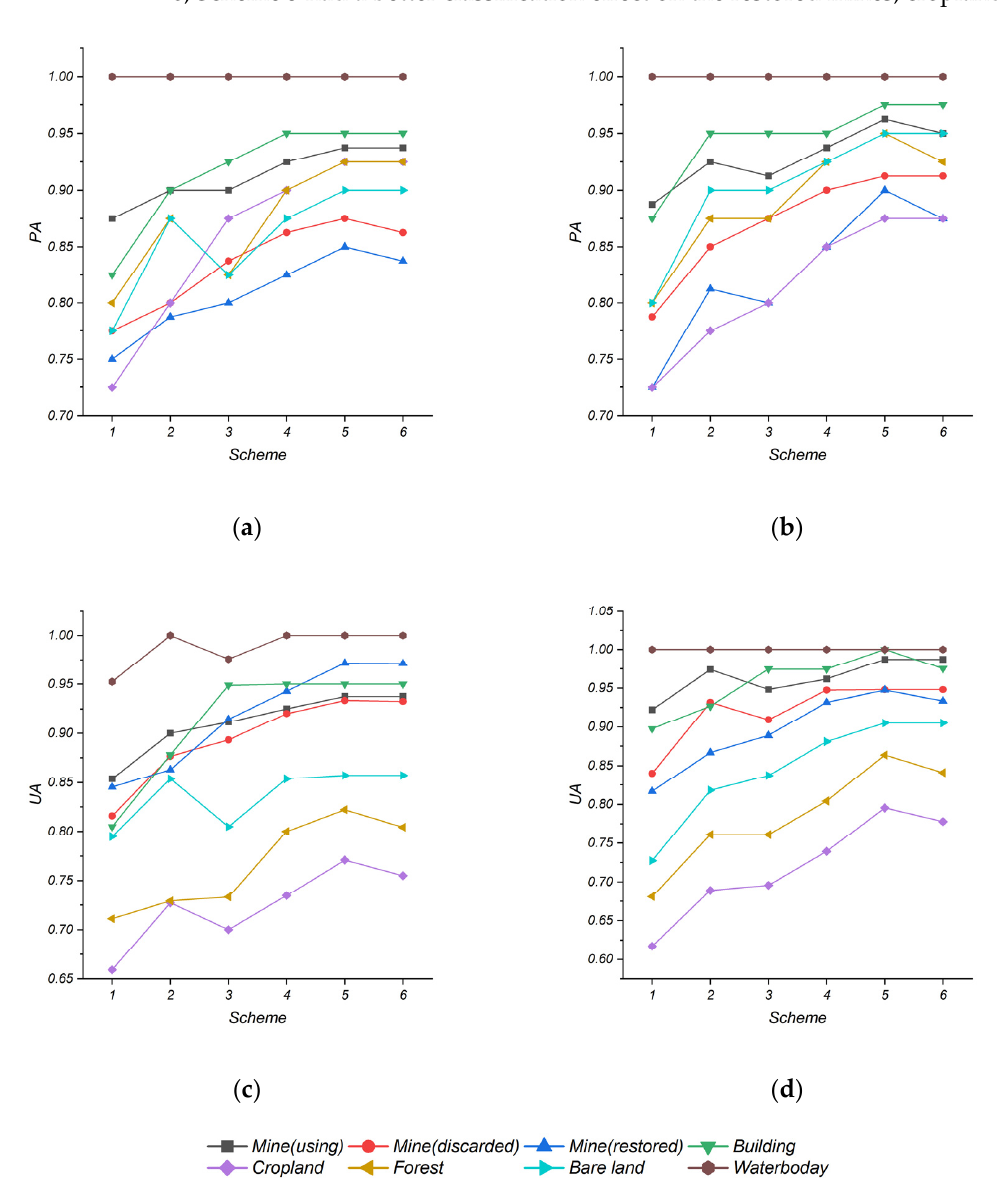
Figure 11. (Top) Producer accuracy (PA) of each type by ( a ) SVM, ( b ) RF; (Bottom) User accuracy (UA) of each type by ( c ) SVM, ( d ) RF.